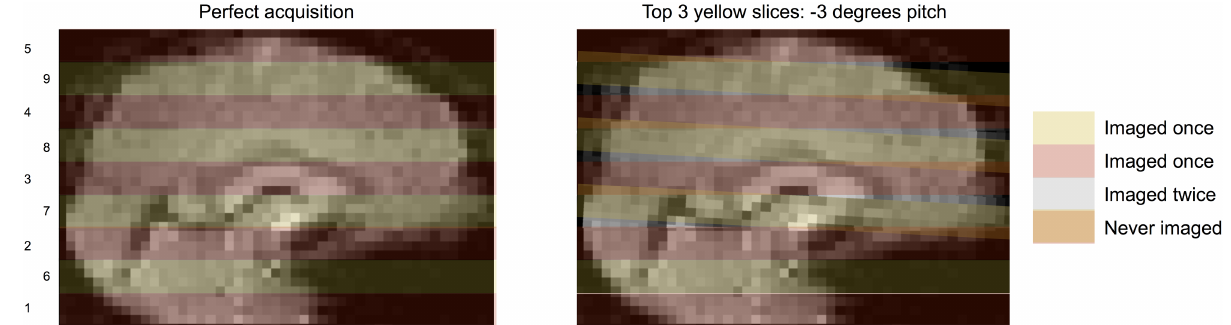
Fig 7. The meaning of image “distortion”. Consider an image acquired in interleaved, ascending fashion. When motion occurs (here, affecting slice acquisitions 7, 8, and 9), the shape of the brain is altered. This shape is often referred to as distorted, but distorted does not mean “warped”. Rather, distortion means that certain parts of the brain are never scannedduringthat timepoint, and other parts of the brain are scannedtwice. There is no way to recover the missing information.